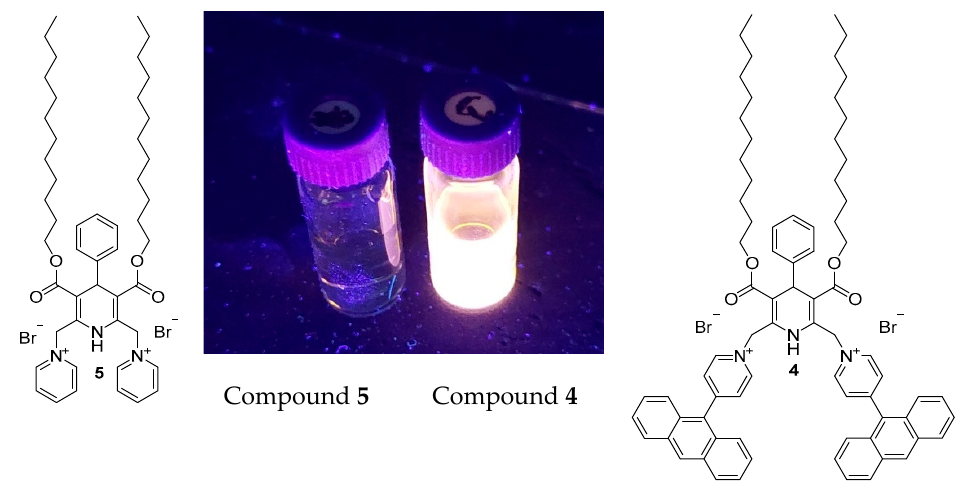
Figure 1. Structures and a visual comparison of the fluorescence of the ethanol solutions of com- pounds 5 and 4 under 365 nm light.